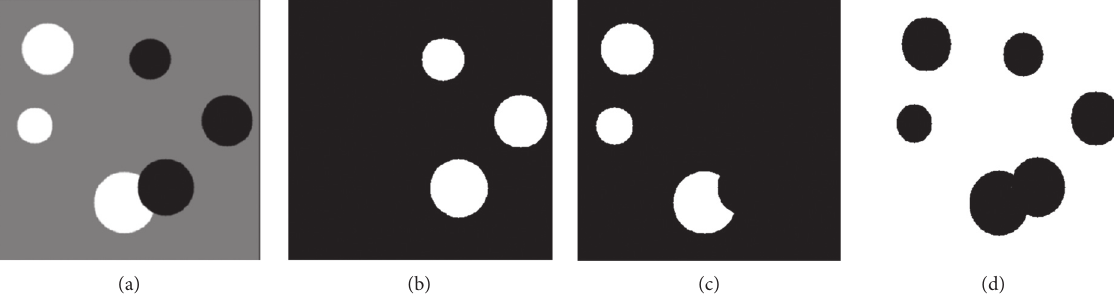
Figure 2: Bilevel thresholding of image into three clusters. (a) Original. (b) c